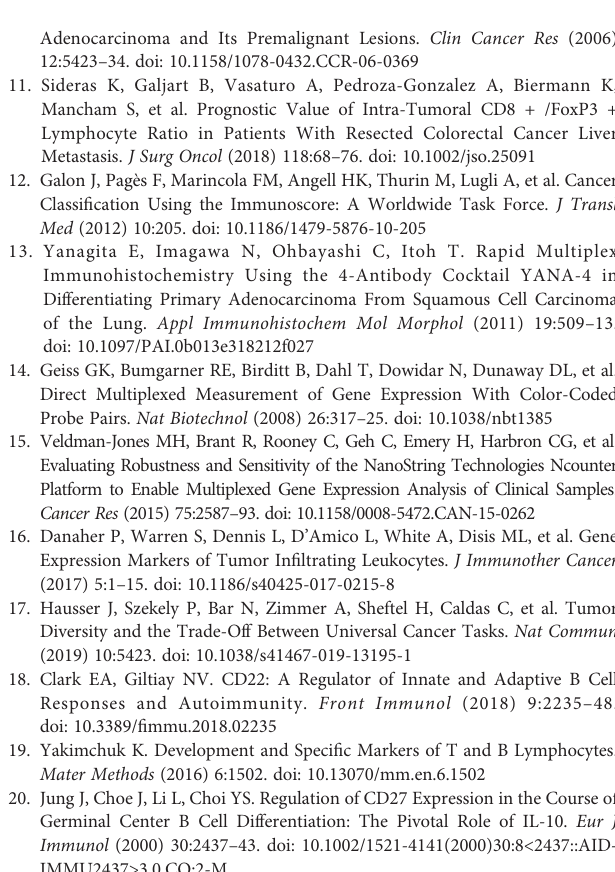
Supplementary Table 1 | The 22 immune cells estimated in PDAC samples using PDAC-MGICs and LM22 gene signature (CIBERSORTx). Supplementary File 1 | Detailed information about all marker genes that were chosenascandidategenes(PDAC-cMG),andtheselected markergenestoidentify immune cells in PDAC (PDAC-MGICs). The fi le contains all the pairwise similarity values between genes used to identify the immune cells in PDAC tissue samples. Genes highlighted with green were selected to identify immune cells; genes highlighted with red were not selected. The pairwise similarity values ≥ 0.6 were highlighted with gray color. Supplementary Figure 1 | The relative scores of B cells in 4 types of PDAC tissue samples of patients who were subjected to (neo)adjuvant therapy. The relative scours of B cells were calculated using the PDAC-MGIC (purple), or the default genes in nSolver ® software, the Advanced Analysis module (yellow). Supplementary Figure 2 | The relative scores of exhausted T cells in 4 types of PDAC tissue samples of patients who were subjected to (neo)adjuvant therapy. The relative scours of exhausted T cells were calculated using the PDAC-MGIC (purple), or the default genes in nSolver ® software, the Advanced Analysis module (yellow). Supplementary Figure 3 | The relative scores of macrophages in 4 types of PDAC tissue samples of patients who were subjected to (neo)adjuvant therapy. The relative scours of macrophages were calculated using the PDAC-MGIC (purple), or the default genes in nSolver ® software, the Advanced Analysis module (yellow). Supplementary Figure 4 | The relative scores of neutrophils in 4 types of PDAC tissue samples of patients who were subjected to (neo)adjuvant therapy. The relative scours of neutrophils were calculated using the PDAC-MGIC (purple), or the default genes in nSolver ® software, the Advanced Analysis module